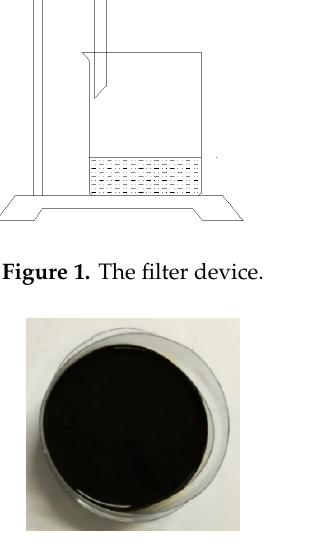
Figure 2. Filtered waste engine oil (WEO).